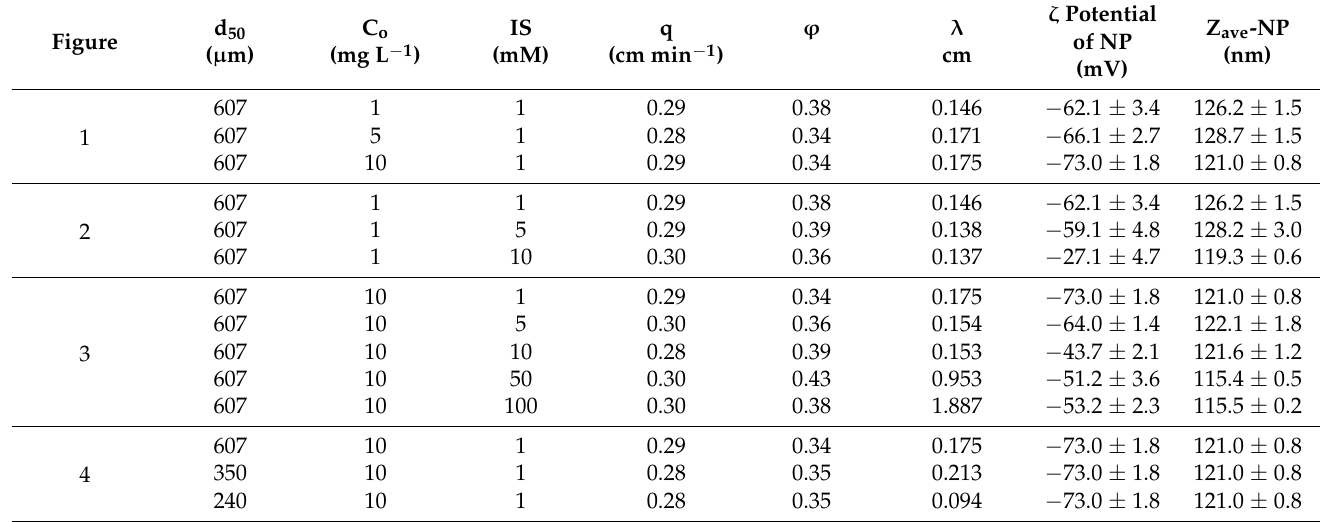
Table 1. PAM@MNP and QS characteristics and setup parameters for column